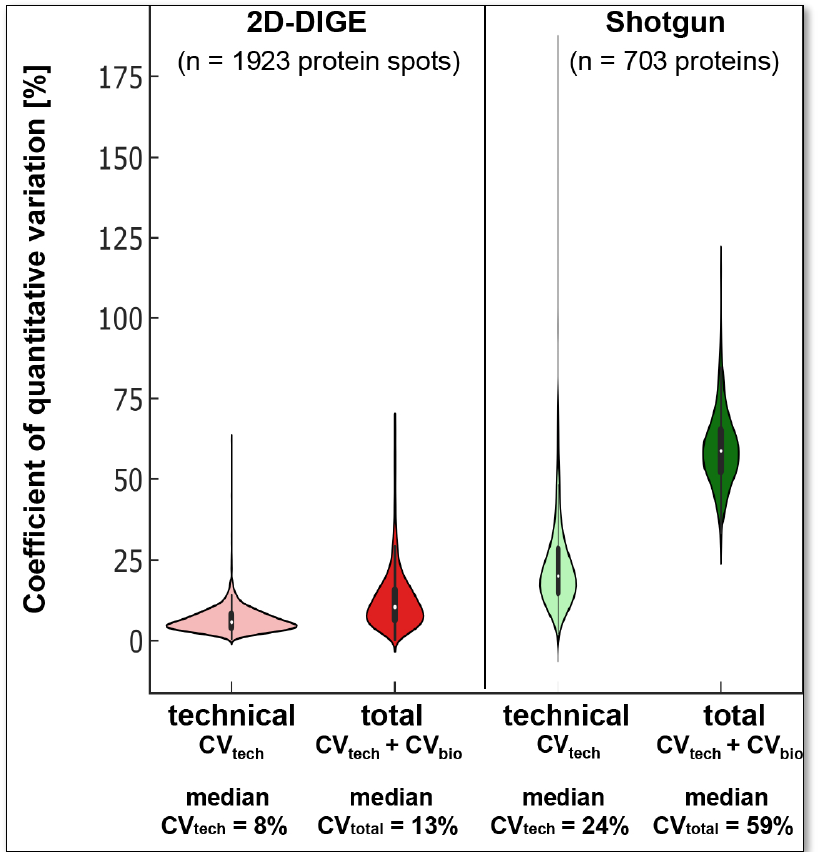
Figure 3. Overall technical and biological quantitative variation in 2D-DIGE and shotgun MS. Vio- lin-blots of technical and total (technical + biological) quantitative variations (CV total ) in 2D-DIGE and shotgun MS. Abbreviations: 2D-DIGE — two-dimensional difference gel electrophoresis; CV tech — technical coefficient of variation, CV bio — biological coefficient of variation; CV total — total coef- ficient of